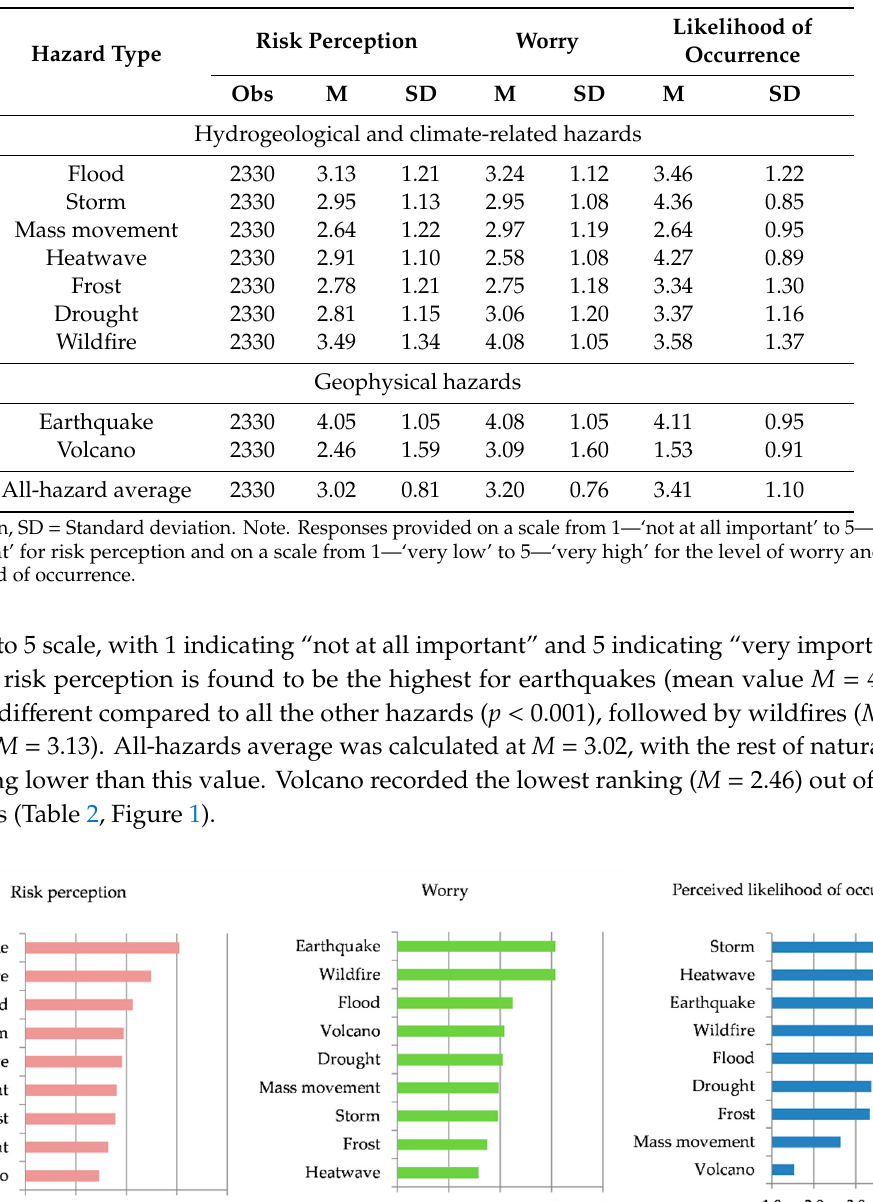
Table 2. Descriptive data for the variables of threat perceptions.